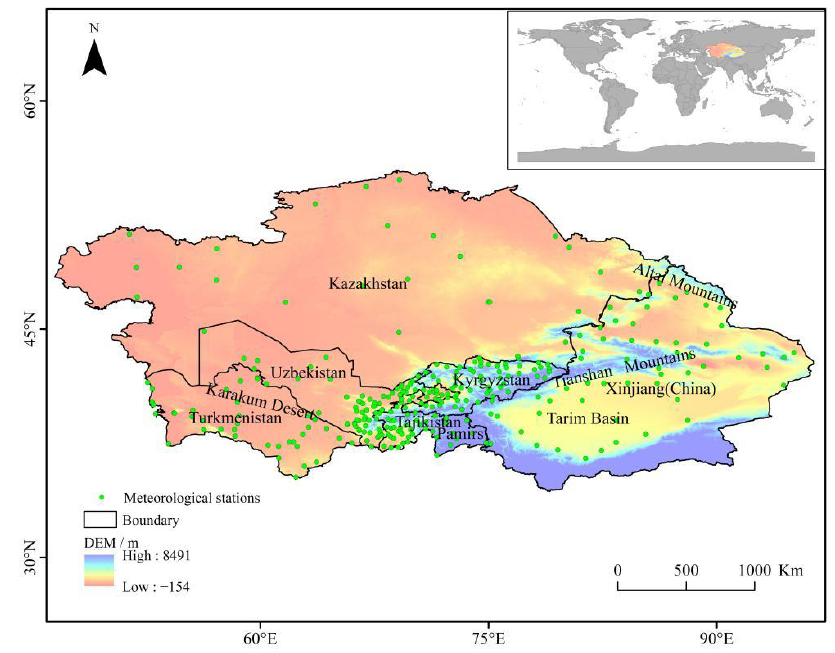
Figure 1. Distribution map of meteorological stations across arid Central Asia.